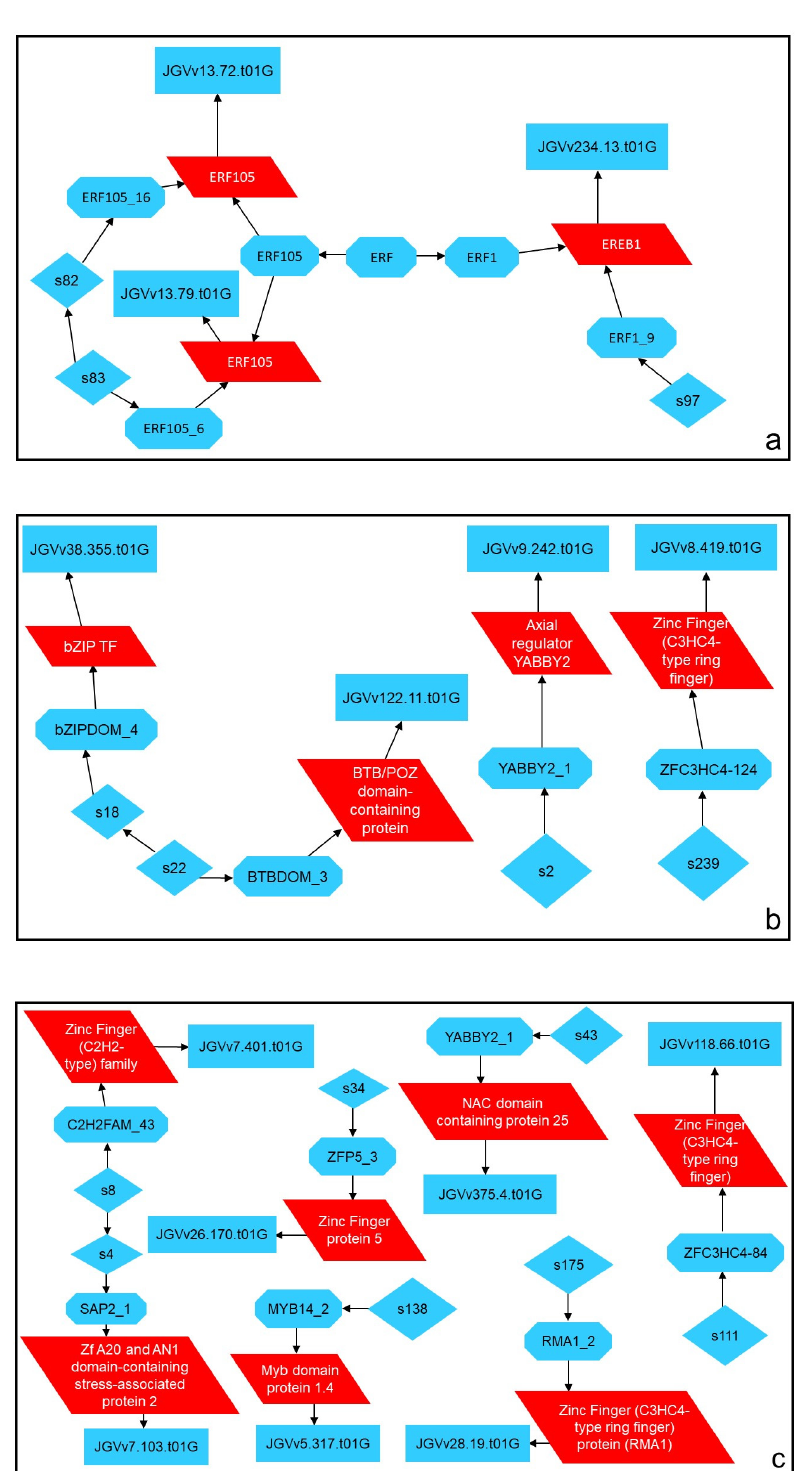
Figure 7. Cytoscape analysis of significantly up- or downregulated ethylene response factors ( a ) and transcription factors of interest ( b , c ) in regulated deficit irrigation (RDI); studied through RT-qPCR. The DEGs monitored in this project are highlighted in red. Rectangles represent genes, parallelograms represent RNAs, octagons represent proteins, and diamonds represent ions. This network was obtained by selecting our transcripts in the VitisNET network and selecting its first neighbors and its directed outgoing